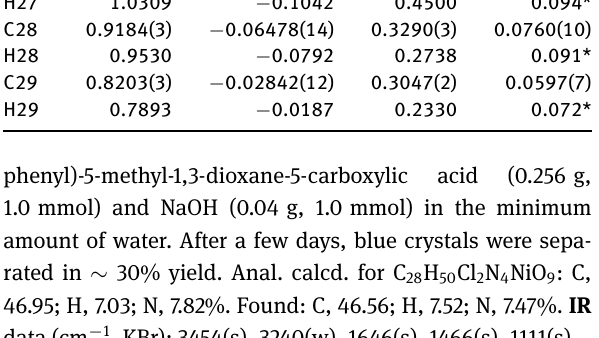
Experimental details Hydrogen atoms were placed in their geometrically idealized positions and constrained to ride on their parent atoms. Discussion Ketals have a subject of interest because they are usually